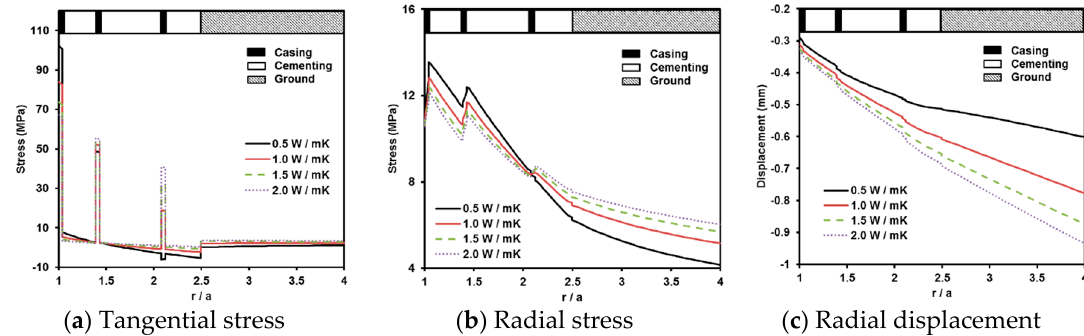
Figure 6. Stress and displacement at 200 m with variation of thermal conductivity of the cementing component.